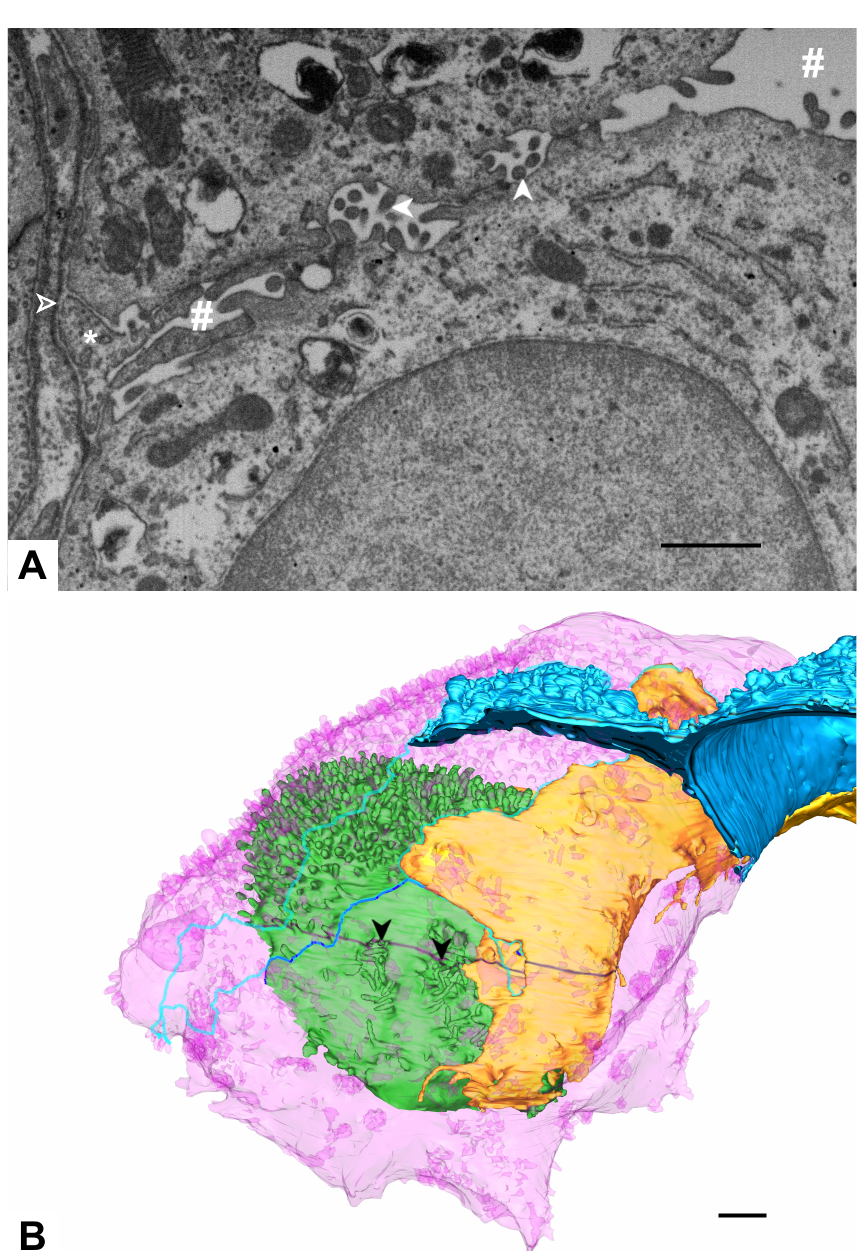
Figure 12. AE2/AE2 contact. ( A ) EM image 1112. The image shows the green (top) and pink (bottom) AE2 cell contacting each other. Both cells show niches with microvilli on their basolateral surface facing each other (filled arrowheads). Between both cells also parts of the yellow AE1 cell domain are found (asterisk). The alveolar lumen is indicated by the hash key and the basal lamina by an empty arrowhead. ( B ) 3D model of the pink and green AE2 cell as well as the yellow and blue AE1 cell domains. The image plane of A is indicated in black. Arrowheads correspond to the arrowheads in A. The borders of the luminal/abluminal surface of the AE2 cells are indicated by turquoise (pink cell) and blue lines (green cell) (cf.Figure 3). The pink AE2 cell and its luminal/abluminal border are displayed transparently to visualize the green AE2 cell and yellow AE1 cell domain behind as well as the luminal/abluminal border of the green AE2 cell. Note the well defined niches with microvilli on the basolateral surface of the green AE2 cell (black arrowheads). Scale bars: 1 µ